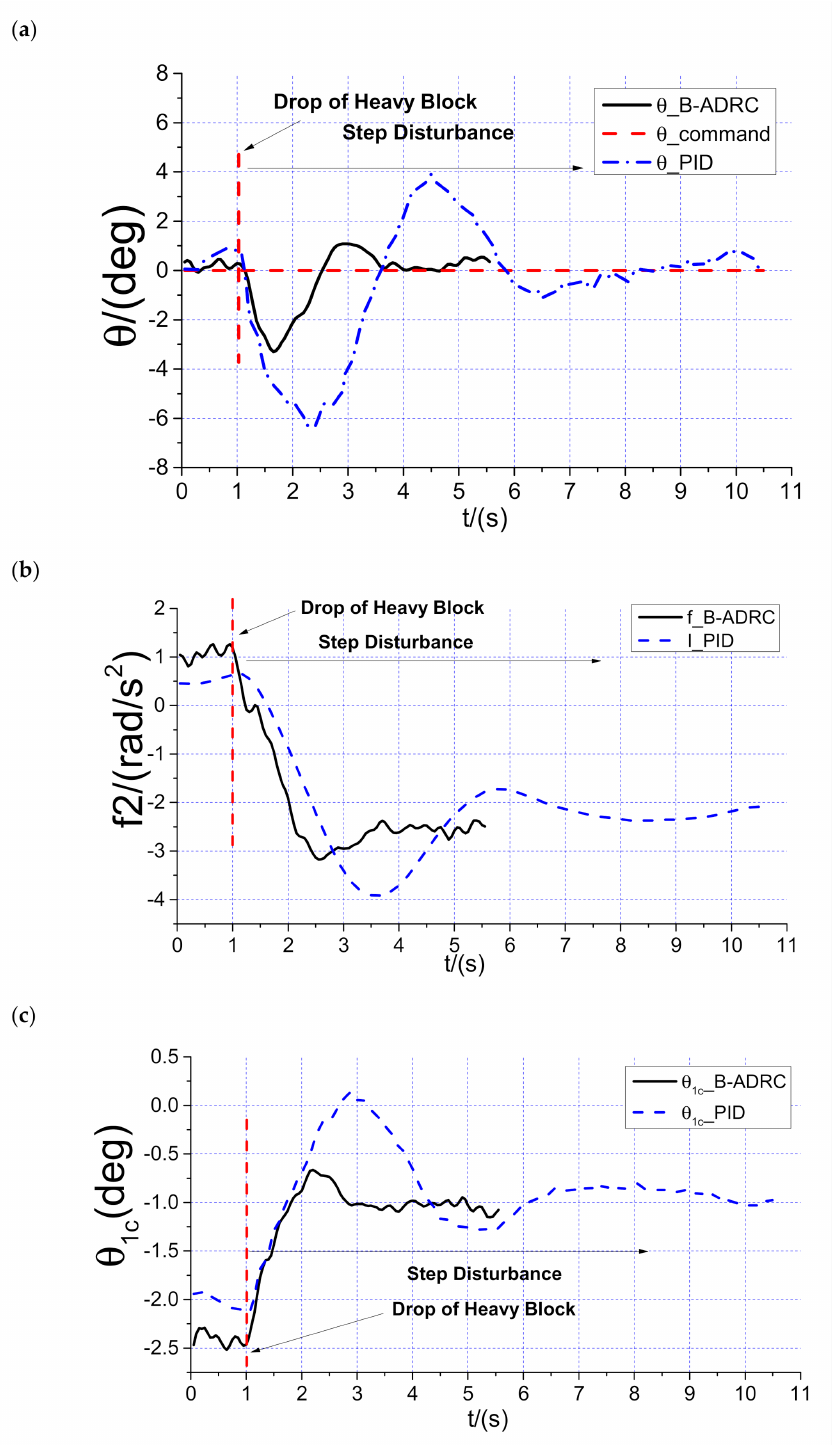
Figure 9. Flight test data of disturbance rejection (I_PID denotes the integral term of the PID controller). ( a ) Tracking of pitch angle; ( b ) estimation of disturbance; ( c ) longitudinal cyclic pitch angle of main